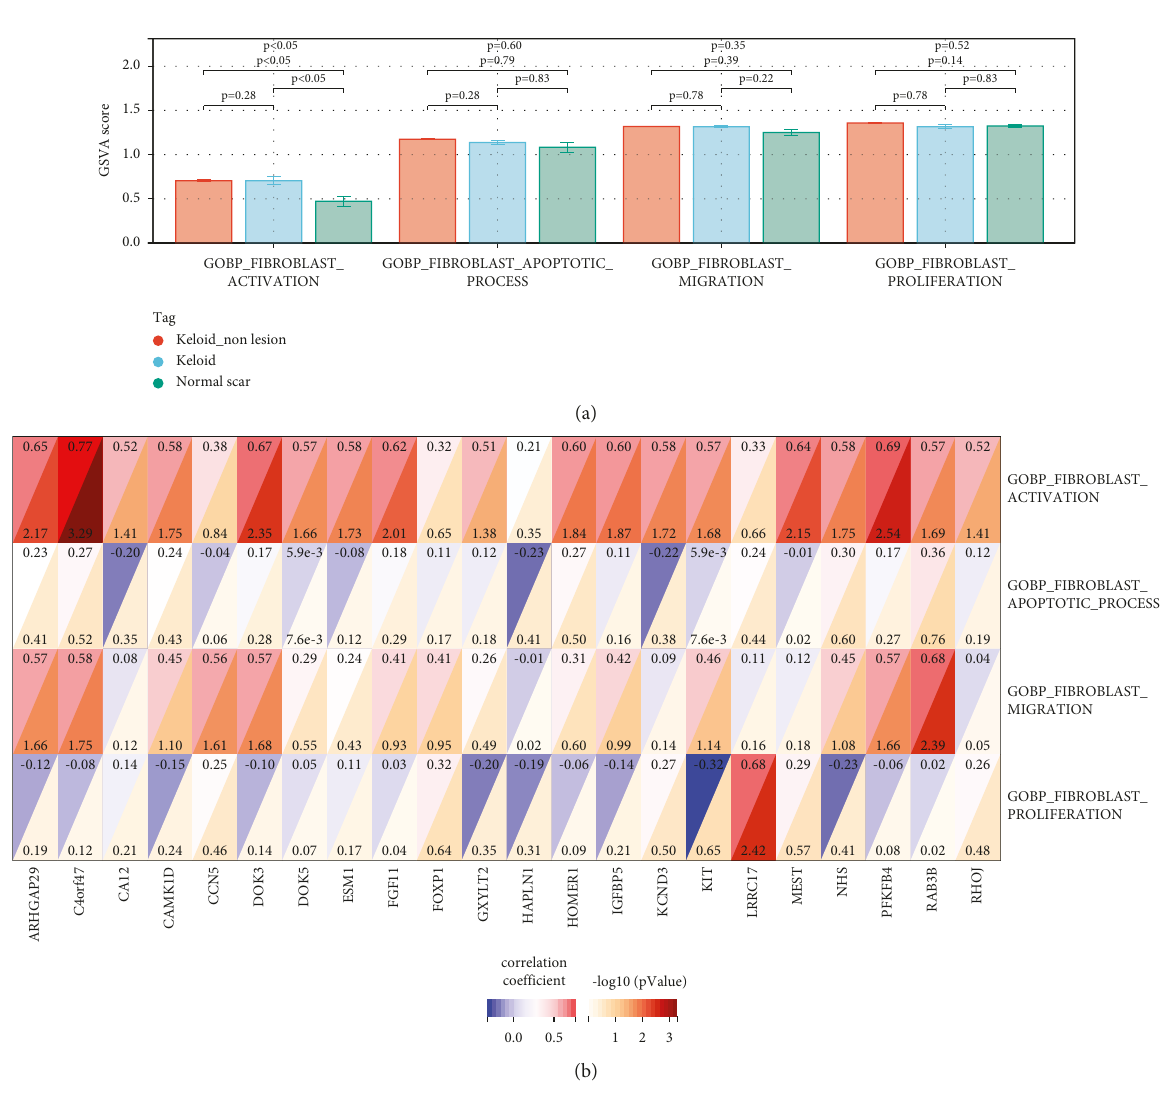
Figure 3: Comparison of enrichment scores of fibroblast-related pathways in keloid and nonkeloid lesions contrary to normal scar and their correlations with the expression levels of